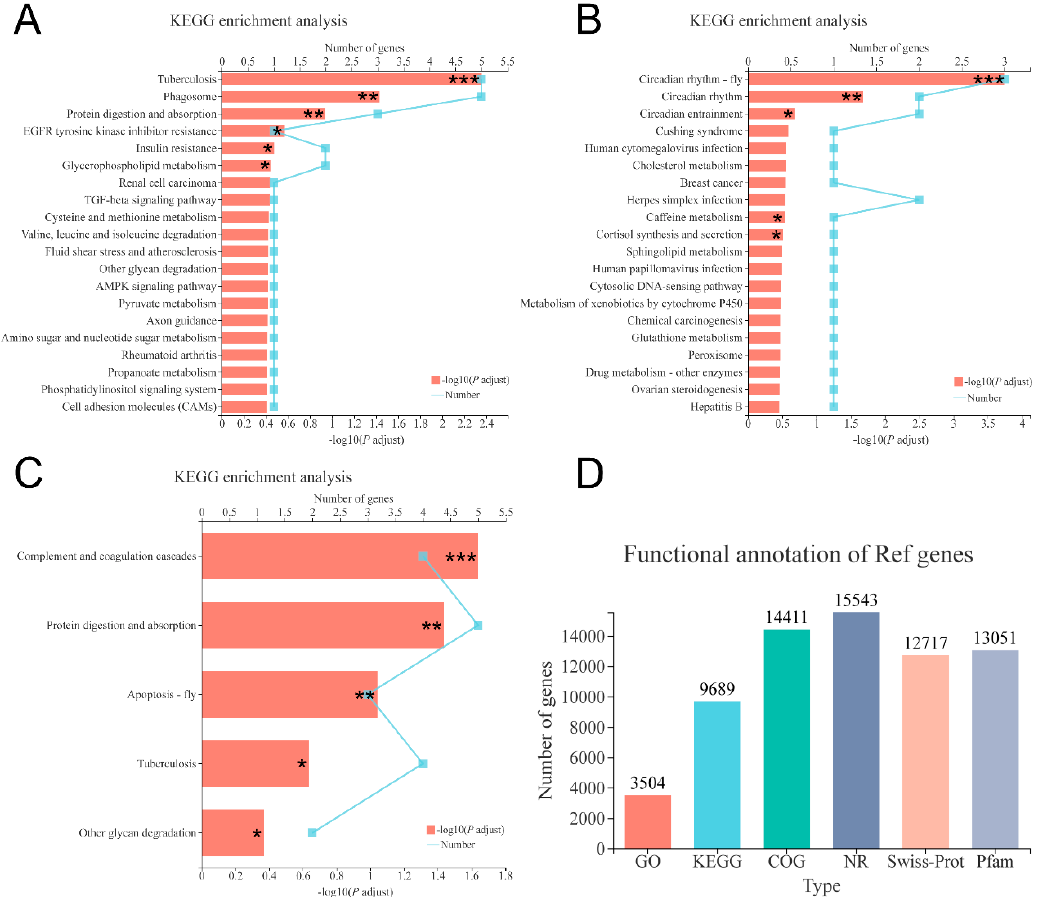
Figure 5. KEGG enrichment analysis based on DEGs in the three compared groups: ( A ) 0 versus 6000 mg/kg; ( B ) 0 versus 12,000 mg/kg; ( C ) 6000 versus 12,000 mg/kg. ( D ) Functional annotation information of genes obtained from six databases. Levels of significance are defined as * ( p < 0.05), ** ( p < 0.01) and *** ( p < 0.001).